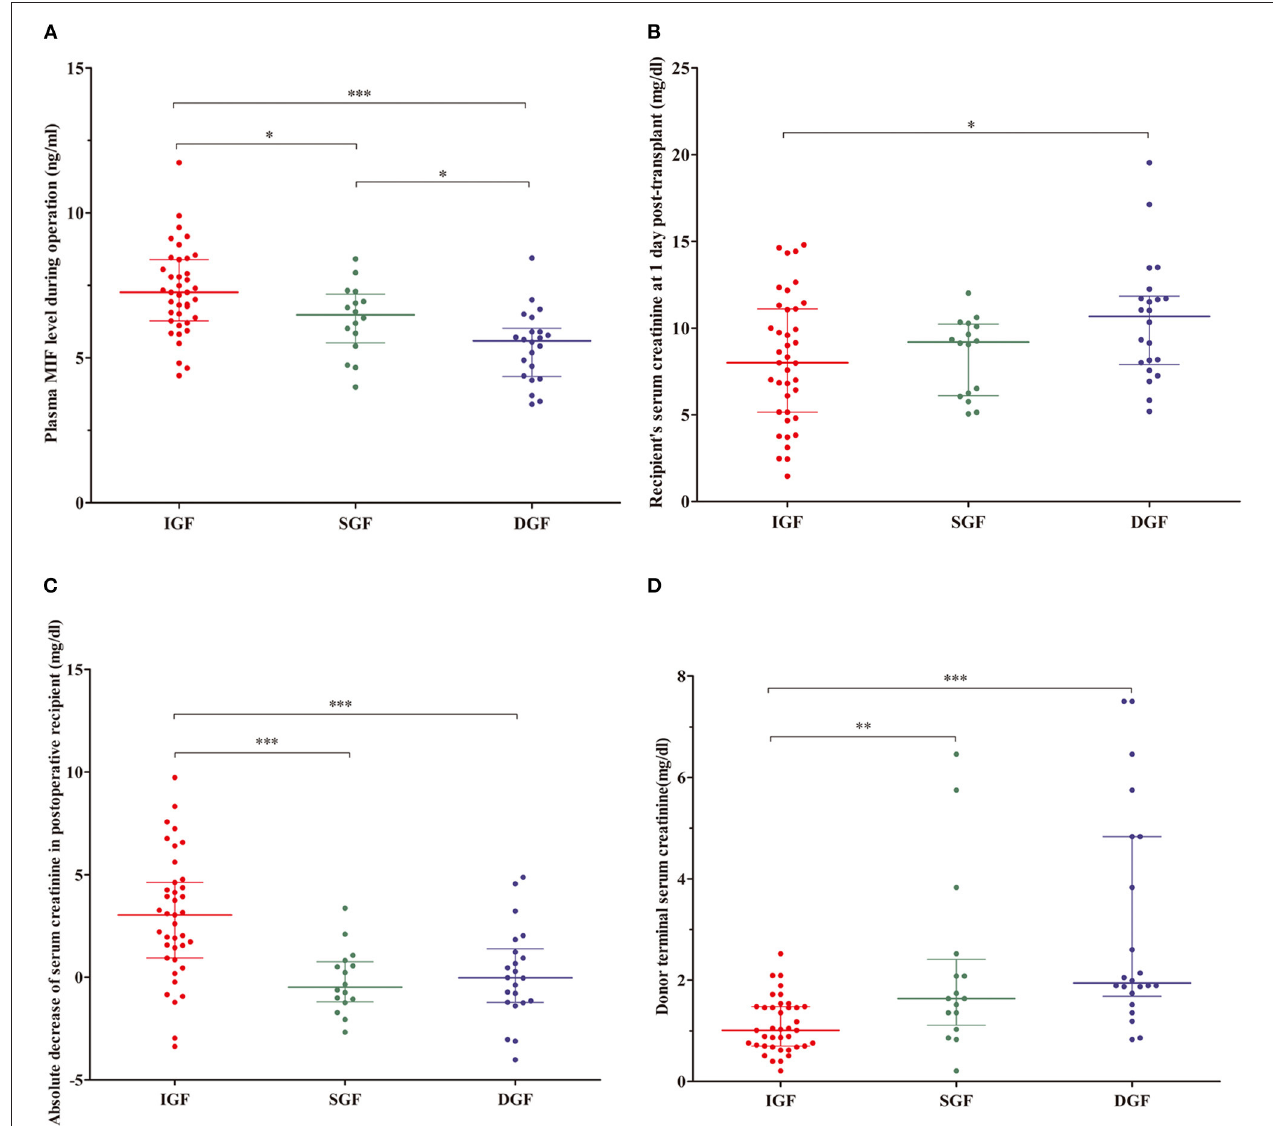
FIGURE 2 | (A) Distributions of plasma macrophage migration inhibitory factor (MIF) from recipient during operation, recipient’s serum creatinine (Scr) at 1-day post-transplant, absolute Scr decrease from 0-h to 1-day post-transplant, and donor terminal Scr in the recipient. (B–D) Contents of MIF, recipient’ Scr at 1-day post-transplant, absolute Scr decrease after transplant, and donor terminal Scr in immediate graft function (IGF; red), slowed graft function (SGF; green), and delayed graft function (DGF; blue) groups. * P < 0.05,** P < 0.01,*** P < 0.001.